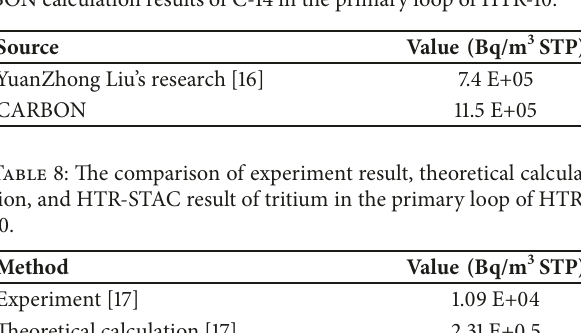
Table 7: The comparison of YuanZhong Liu’s research and CAR- BON calculation results of C-14 in the primary loop of HTR-10.